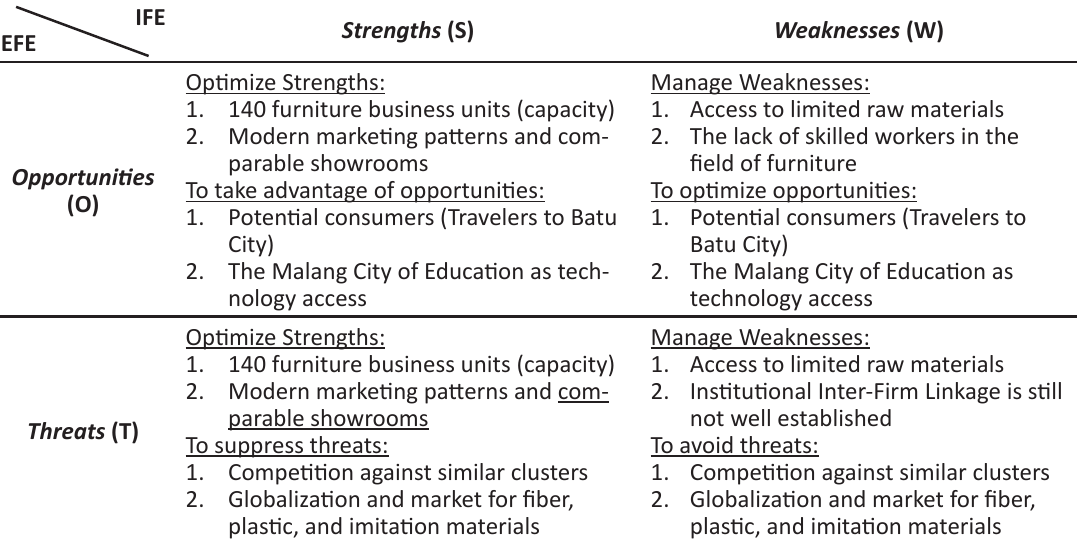
Table 4: SWOT Matrix of Furniture SME Cluster in Malang